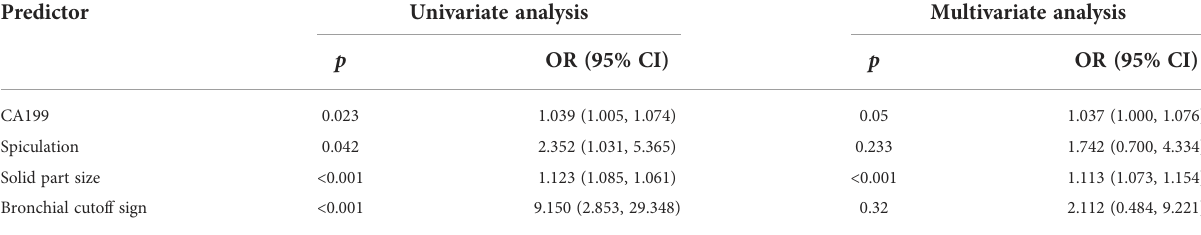
TABLE 2 Univariate and multivariate logistic regression analyses of risk factors for lymph node metastasis.